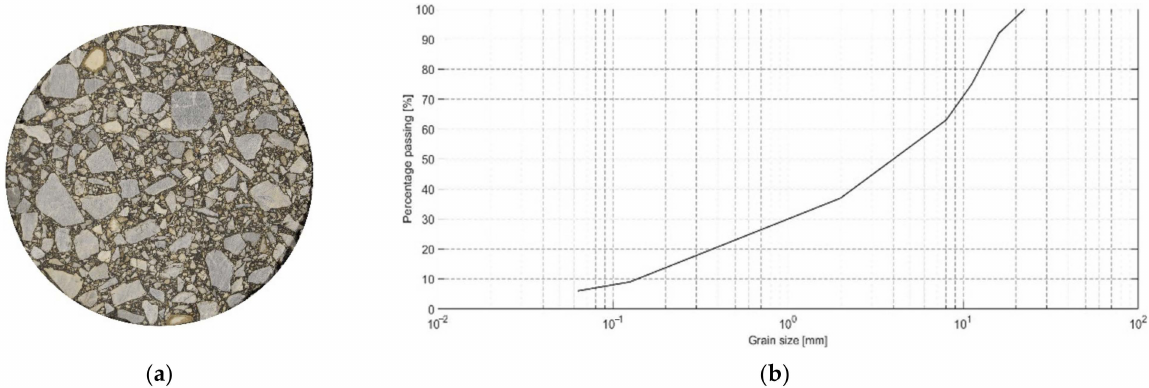
Figure 1. Top view of the cylindrical AC specimen ( a ) and the corresponding gradation curve ( b ). As the mineral aggregate used in AC is obtained via the crushing process, the bound- aries of individual particles exhibit strong irregularities and need to be